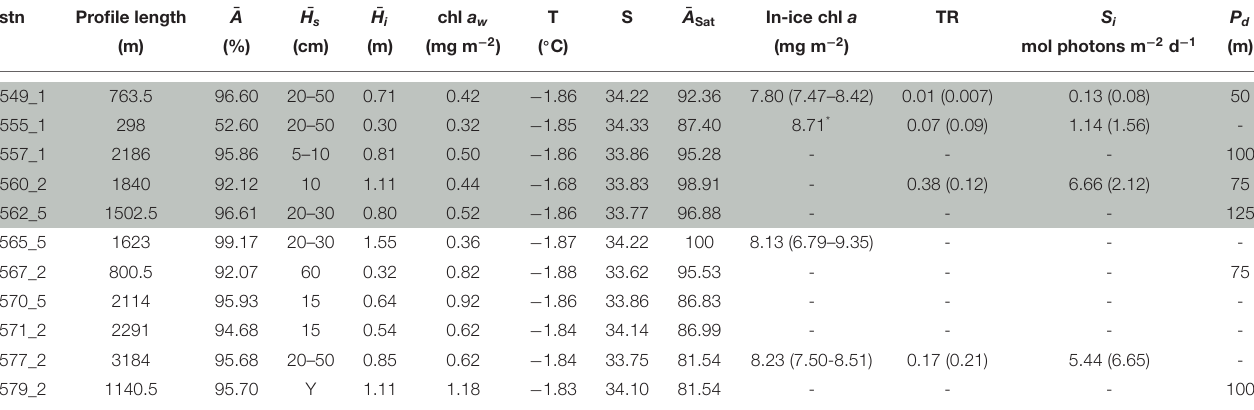
TABLE 6 | Table for PS81 with, for each station (stn), the total profile length, the mean ice concentration ( ¯ A ) along profile, mean snow depth ( ¯ H s ) and mean total ice thickness ( ¯ H i ), under-ice water chl a (chl a w ) multiplied by the vertical section of the SUIT (2m) to obtain integrated values, under-ice water temperature and salinity, ice concentration retrieved from satellite ( ¯ A Sat ), and median in-ice chl a (interquartile range), mean transmittance TR ( ± one standard deviation), mean Insolation S i ( ± one standard deviation), and the draft patch size ( P d ).